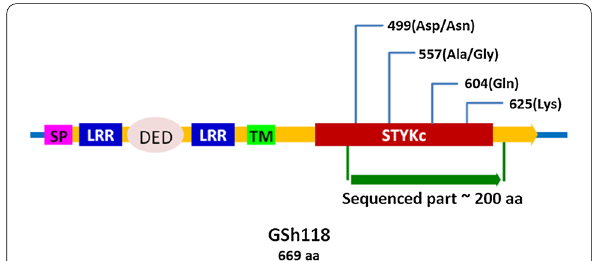
Fig. 6 Schematic representation of the putative protein encoded by the GSH118 gene, showing the domains and positions of SNPs identified in the sequencing region of MCC133 and ILC263